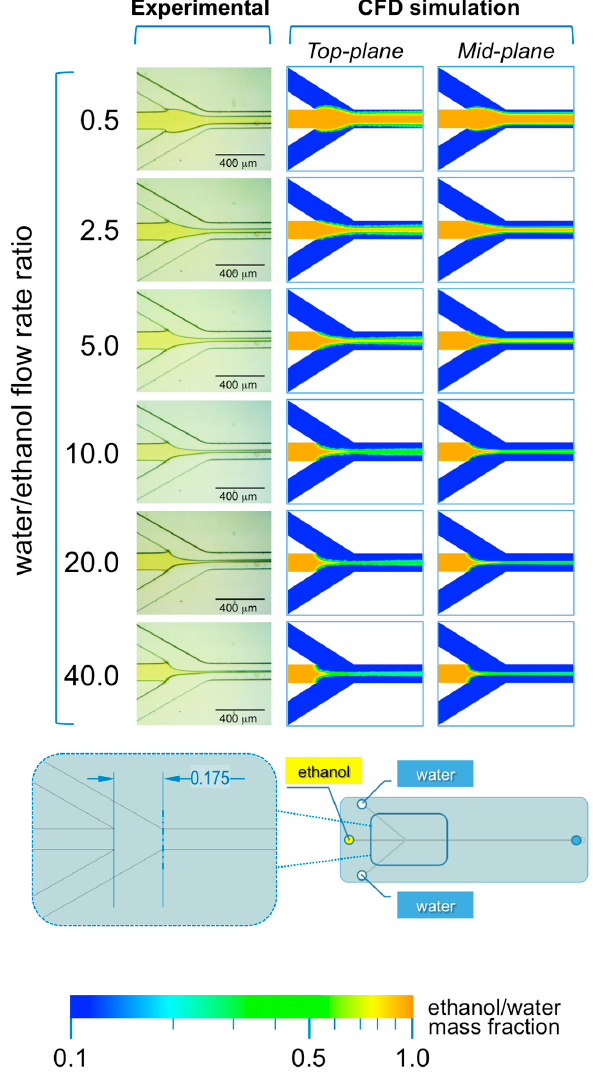
Figure 4. Experimental and computational fluid dynamic (CFD) analysis of the effect of FRR on the shape of the focused stream, in #chip1-MHF. The images illustrate the experimental microscopic observations ( left column ) and the CFD simulations ( mid and right columns ) of the focusing region, at the channels’ intersection; The images were employed to determine the focused stream width at 0.175 mm from the inlet channel, as indicated in the schematic at the bottom; The numerical contours of ethanol mass fraction are reported at both the mid-plane ( mid column ) and top-plane ( right column ) of the device. Experiments and simulations were conducted at TFR of 37.50 µL/min, and at varying FRRs.